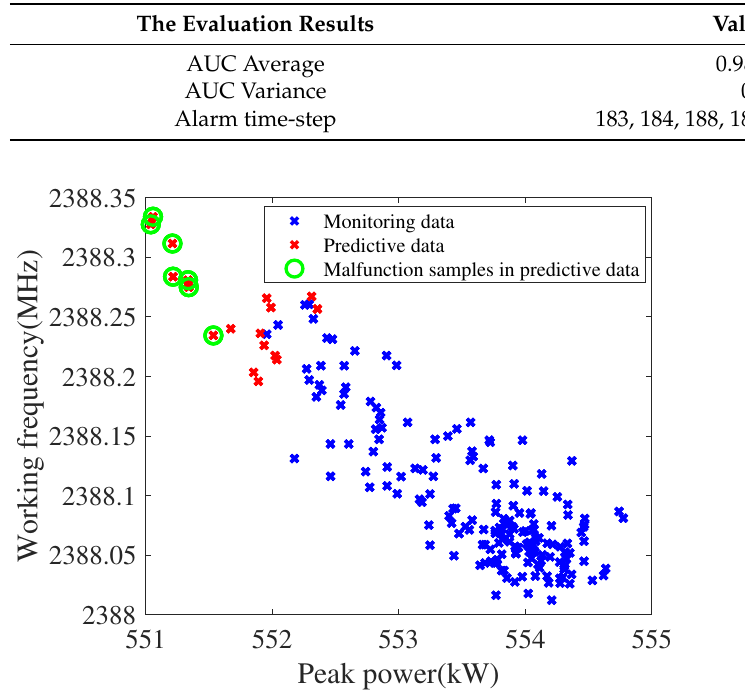
Figure 8. The visualization results of the first type of degradation malfunction prognosis experiment.